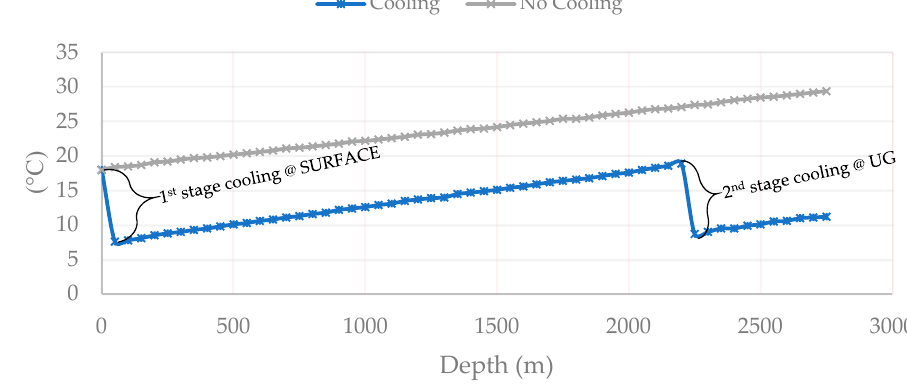
Figure 5. Impact of mine auto ‐ compression.